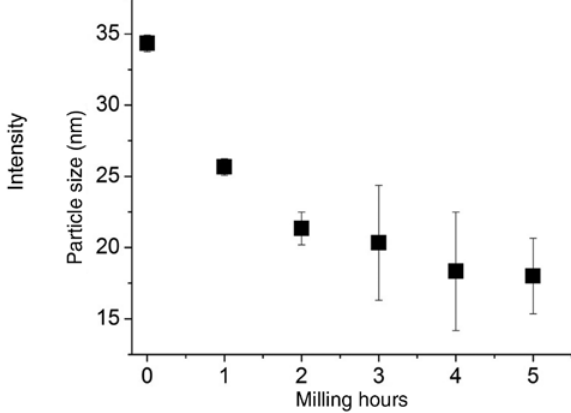
particle size vs. hours of ball 2